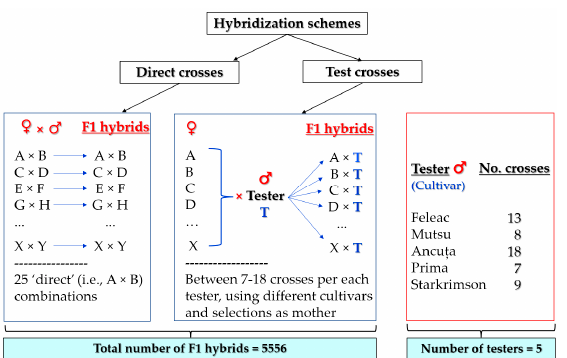
Figure 6. The hybridization schemes performed in the experiment with direct hybridizations and testcrosses.